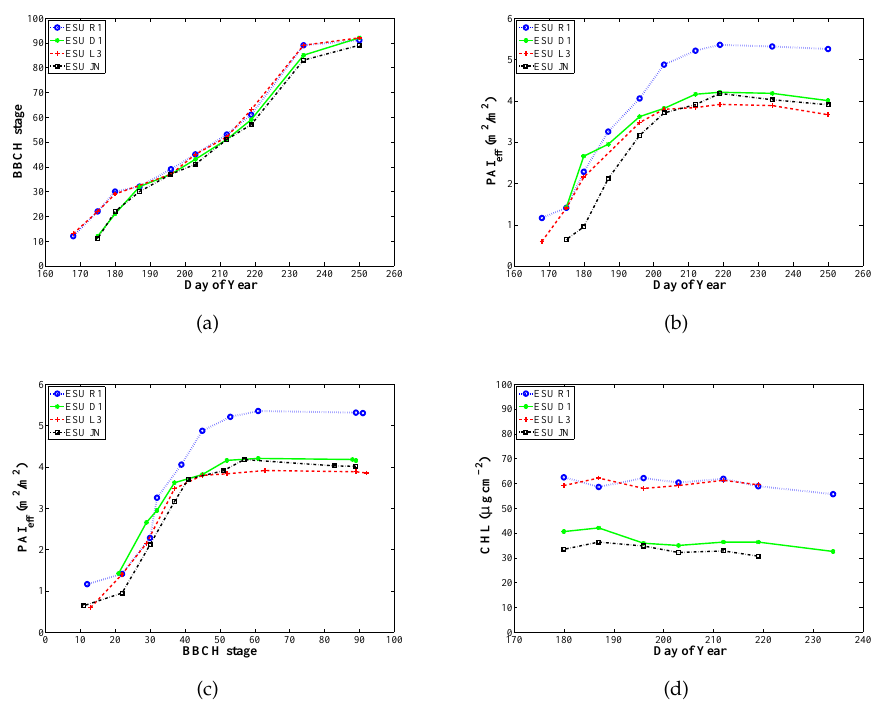
Figure 3. Bio-physical indicators measured in four representative ESUs during the field campaign: ( a ) Phenology according to the (BBCH) scale; ( b ) effective plant area index acquired with PocketLAI; ( c ) effective plant area index related with the BBCH phenological stages; and ( d ) leaf chlorophyll content measured during the rice